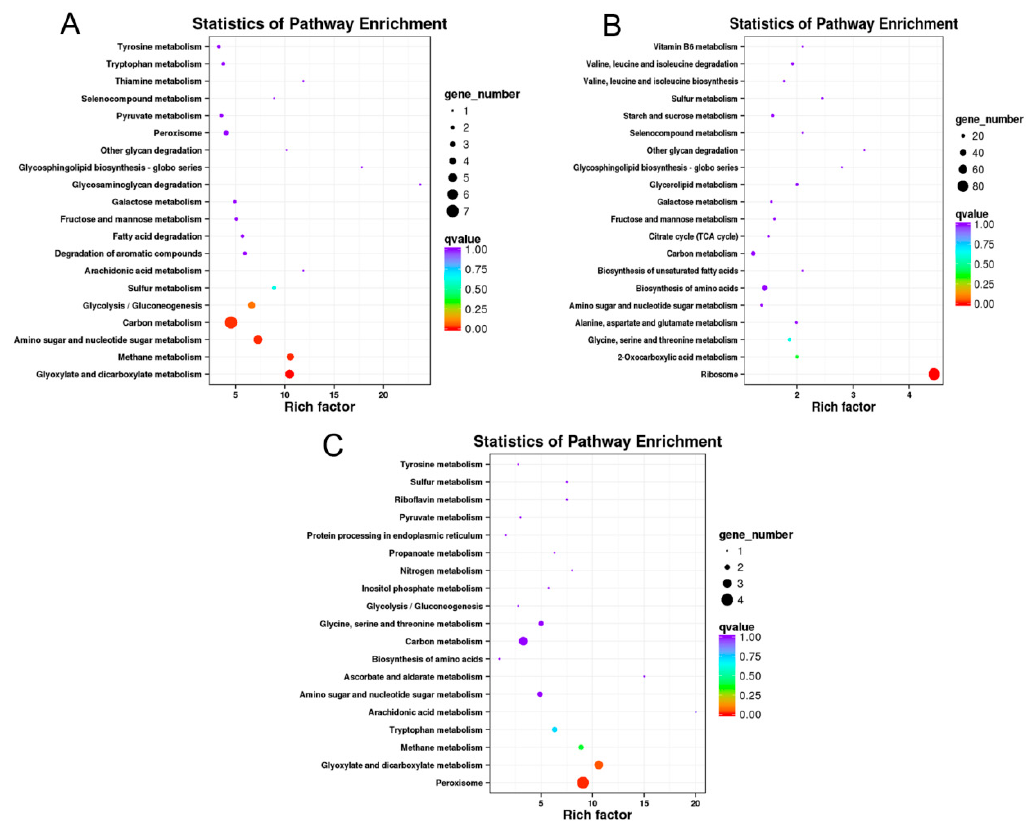
Figure 4. Top 19 KEGG pathway enrichment analysis of annotated DEGs after F. graminearum inoculation on soybean. Significantly enriched Encyclopedia of Genes and Genomes (KEGG) pathway of F. graminearum infection on soybean at 12 ( A), 24 ( B ) and 48 hpi ( C ). Solid dark circle showed the number of expressed genes and q value indicated the adjusted fold change value to <0.005.